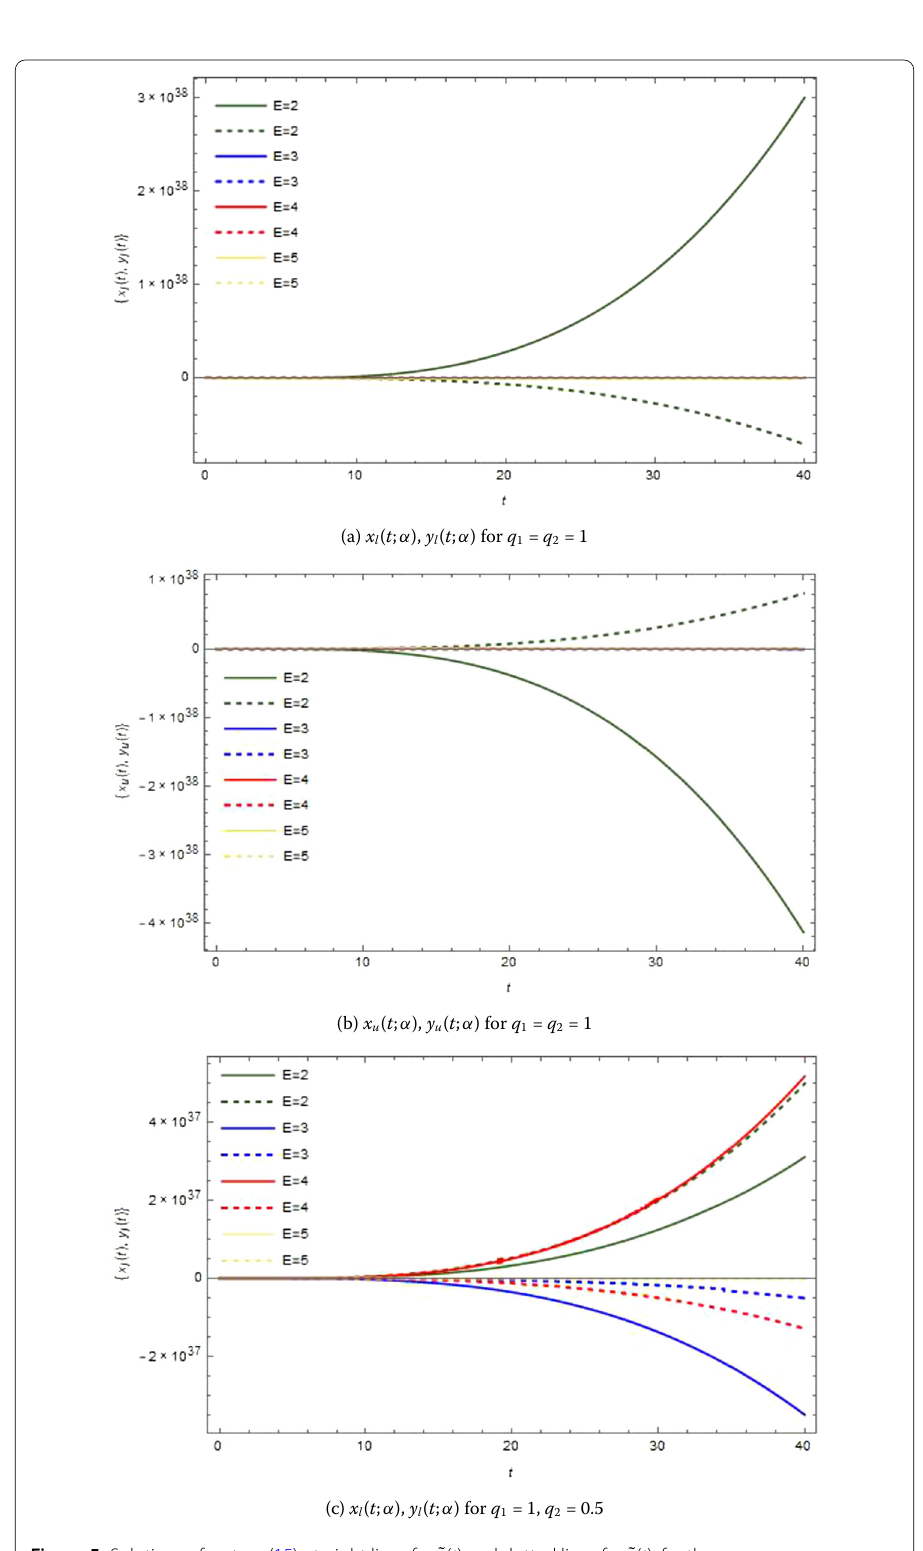
Figure 5 Solutions of system (15), straight lines for ˜ x ( t ) and dotted lines for ˜ y ( t ), for the cases q 1 = q 2 , q 1 > q 2 and q 1 < q 2 at α = 0.98, σ = 0.998 and for different values of